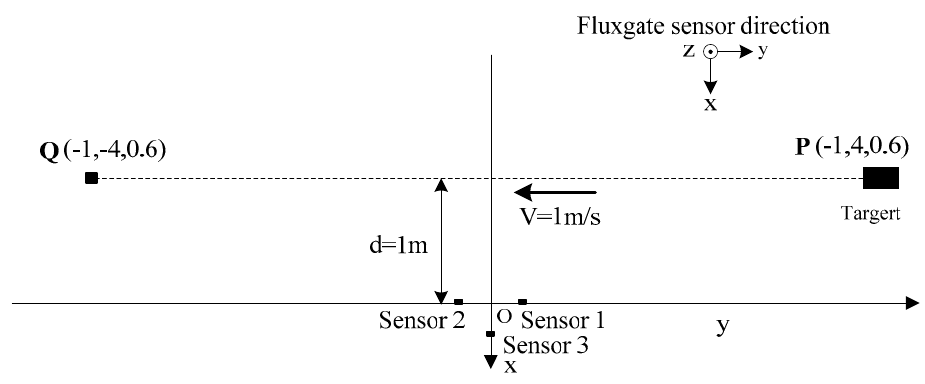
Figure 14. Overhead view of experimental tests.